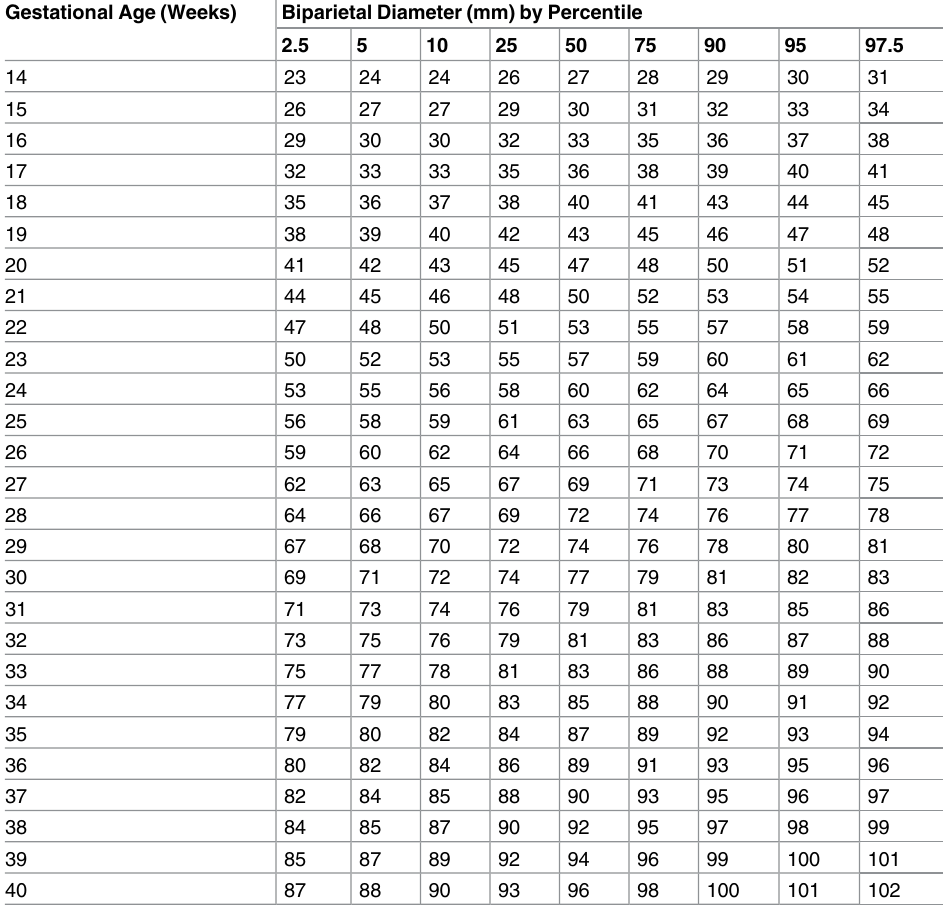
Table 6. Growth chart for fetal outer–inner biparietal